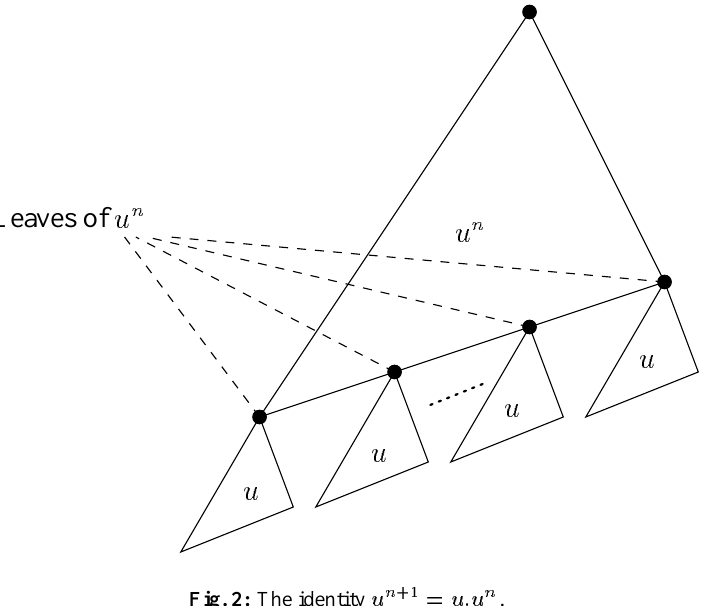
Fig. 2: The identity ❶✔❷☞❸✂❹⑧❺❻❶✽❼☎❶✔❷